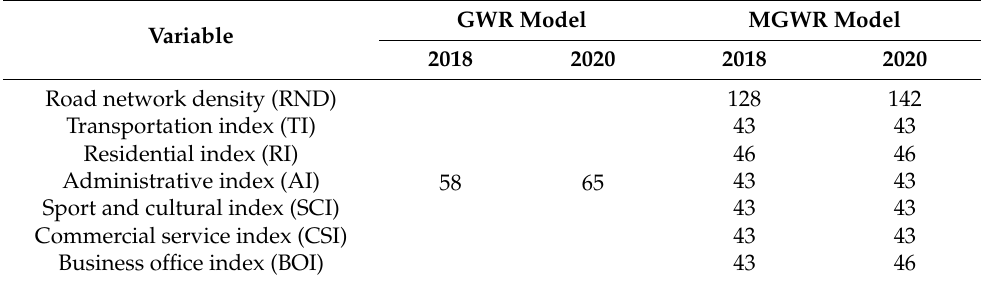
Table 4. The spatial bandwidths of the MGWR